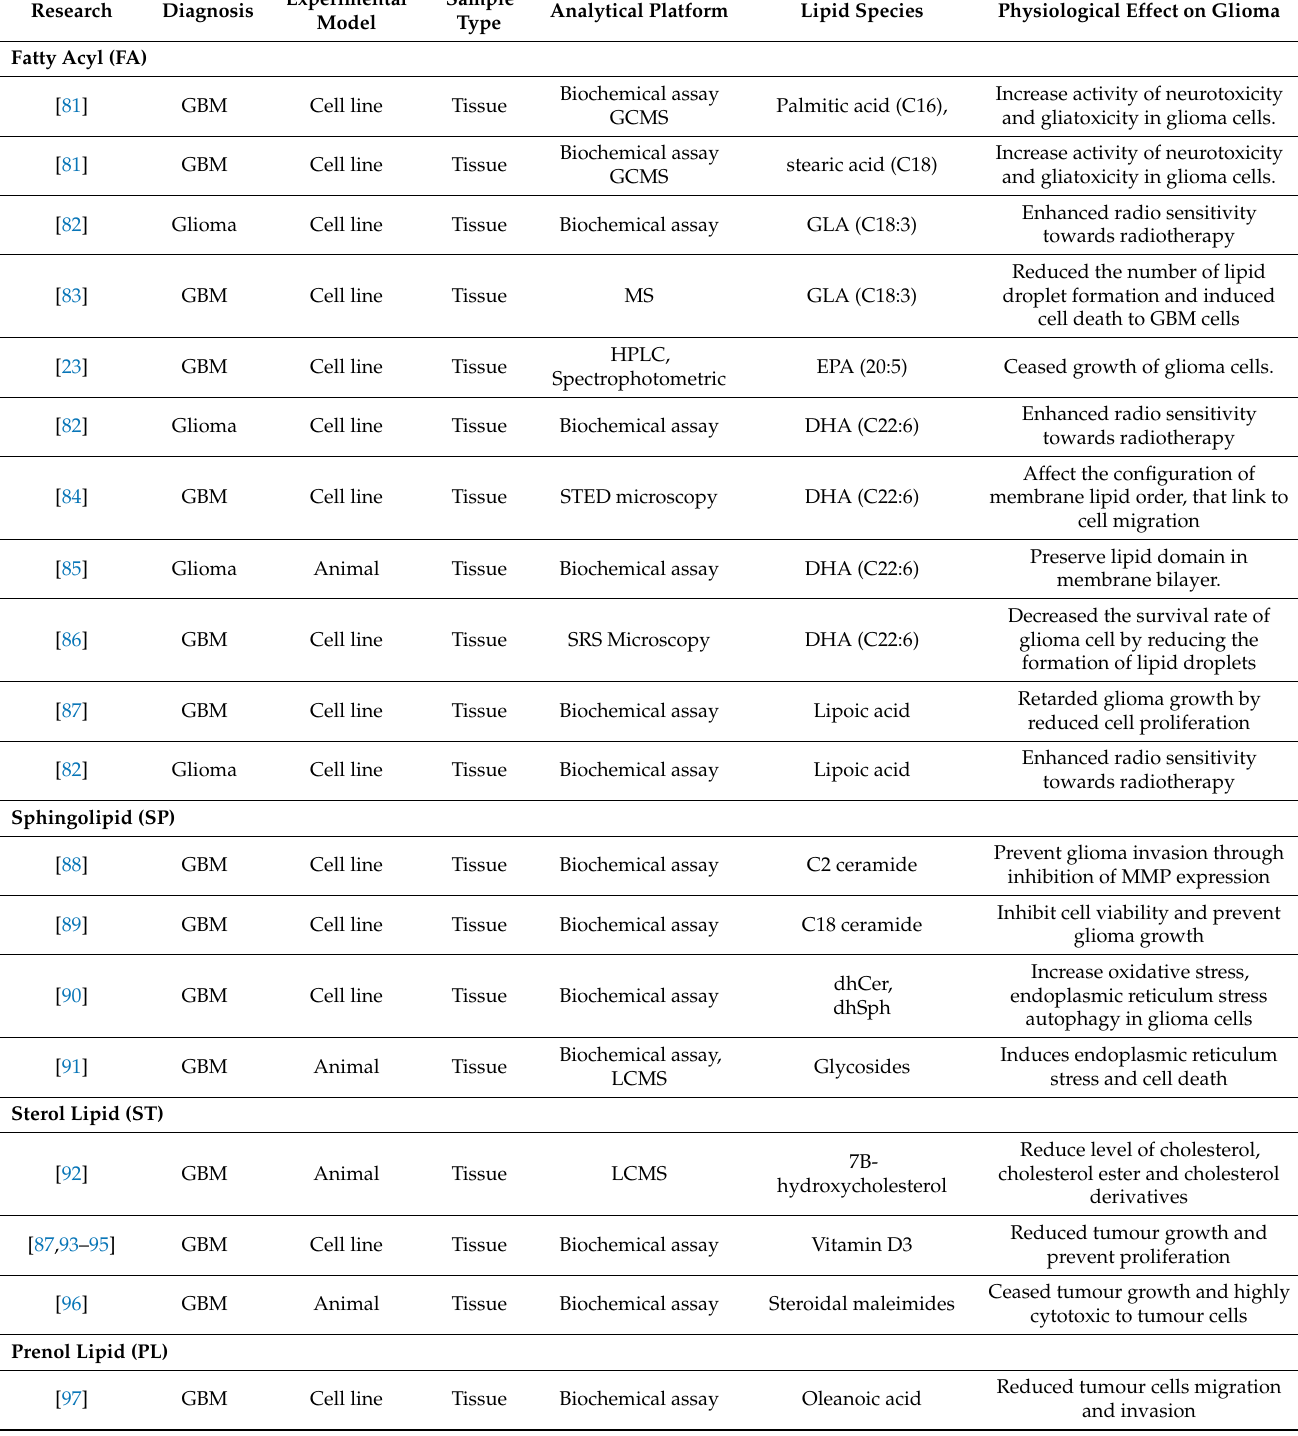
Table 2. Anti-carcinogenic roles of lipid in